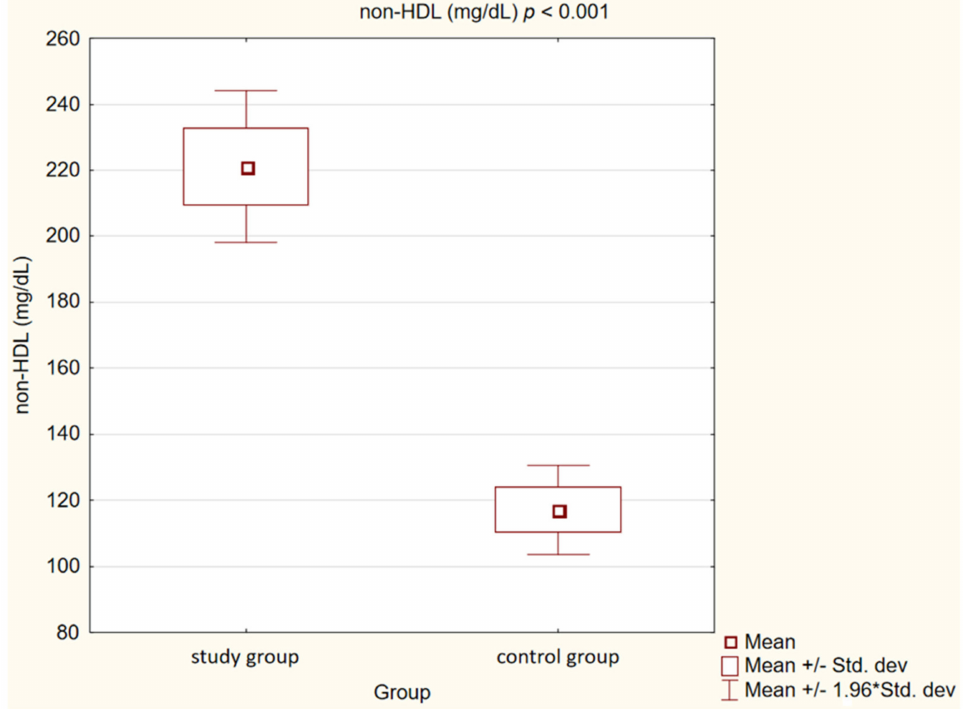
Figure 4. Concentration of non high-density lipoprotein cholesterol (non-HDL) in study and con- trol